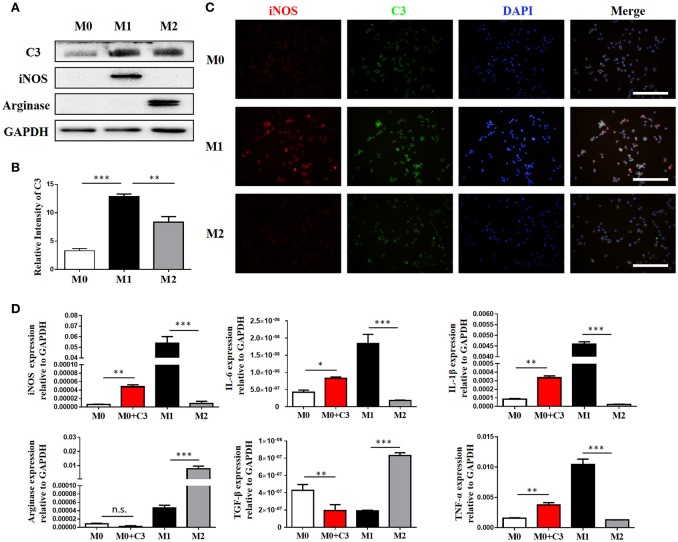
Macrophages are the major source of C3 in the obstructed kidney. (A) The protein isolated from BMMs treated for 24 h with either IFN-γ or IL-4 were analyzed by Western blot analyses, and (B) the histogram shows the relative intensity for each marker normalized to GAPDH. (C) Immunofluorescence staining showing increased C3 (green) primarily expressed in M1 with colocalization with iNOS (red) (original magnification ×400). Scale bar, 50 μm. (D) The effect of exogenous C3 on the subtype of macrophage by real-time PCR. The histogram shows the relative mRNA levels of iNOS, IL-6, IL-1β, Arginase, TGF-β, and TNF-α in these groups. n = 3. The error bars represent the SEM. *P < 0.05; **P < 0.01; ***P < 0.001. The data were pooled from three independent experiments.